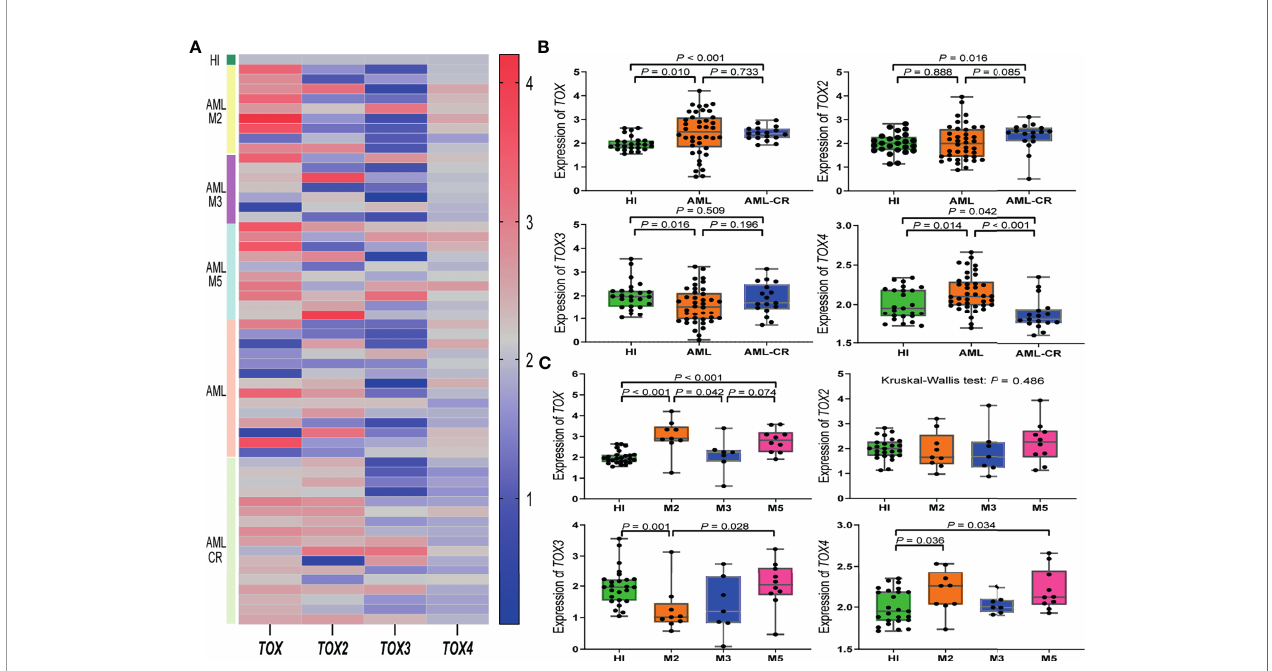
FIGURE 2 | TOX gene expression levels in AML patients. (A) Heatmap of the expression levels of the TOX genes in AML patients from different subtypes and periods compared to a HI. (B) Expression levels of TOX genes in AML (orange) and AML-CR (blue) patients compared to HIs (green). (C) Expression levels of TOX genes in the M2 (orange), M3 (blue), and M5 (pink) subtypes in AML patients compared to HIs (green). CR, complete response; HI, healthy